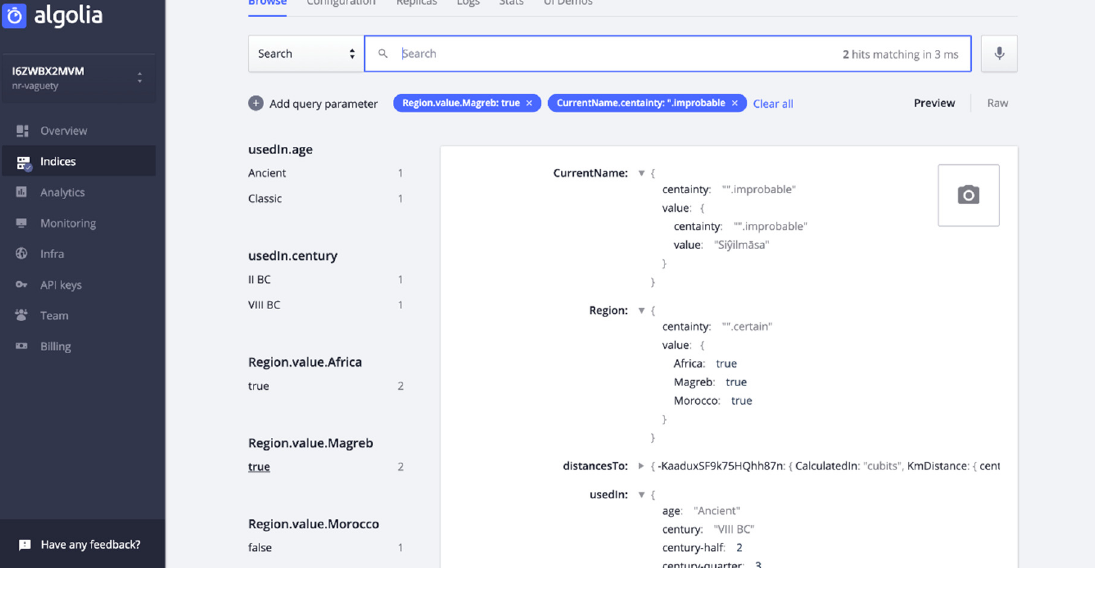
Figure 9 . Results for query A . Figure 9. Results for query A.